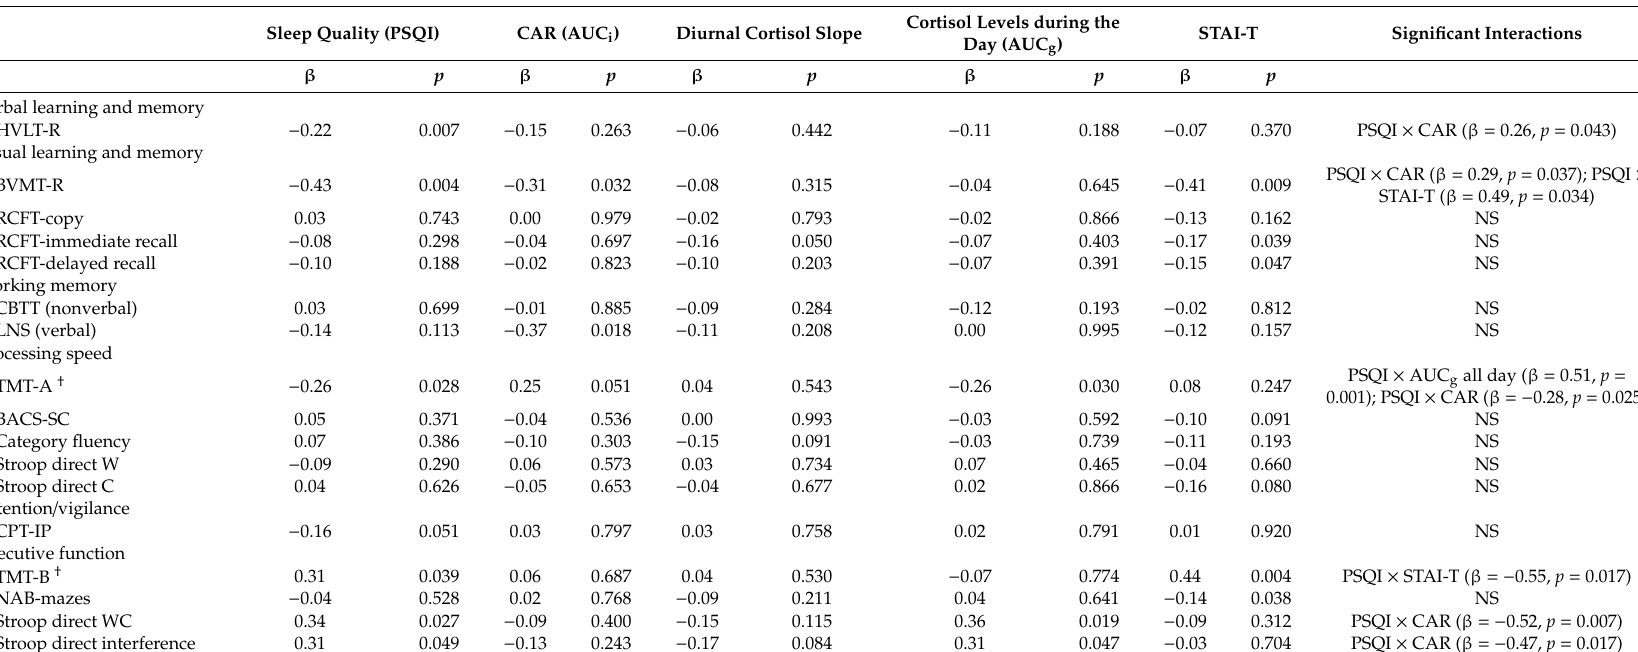
Table 4. Results of the multiple linear regression analyses exploring the relationship between sleep quality, hypothalamic-pituitary-adrenal axis measures, trait anxiety and cognitive functioning in healthy